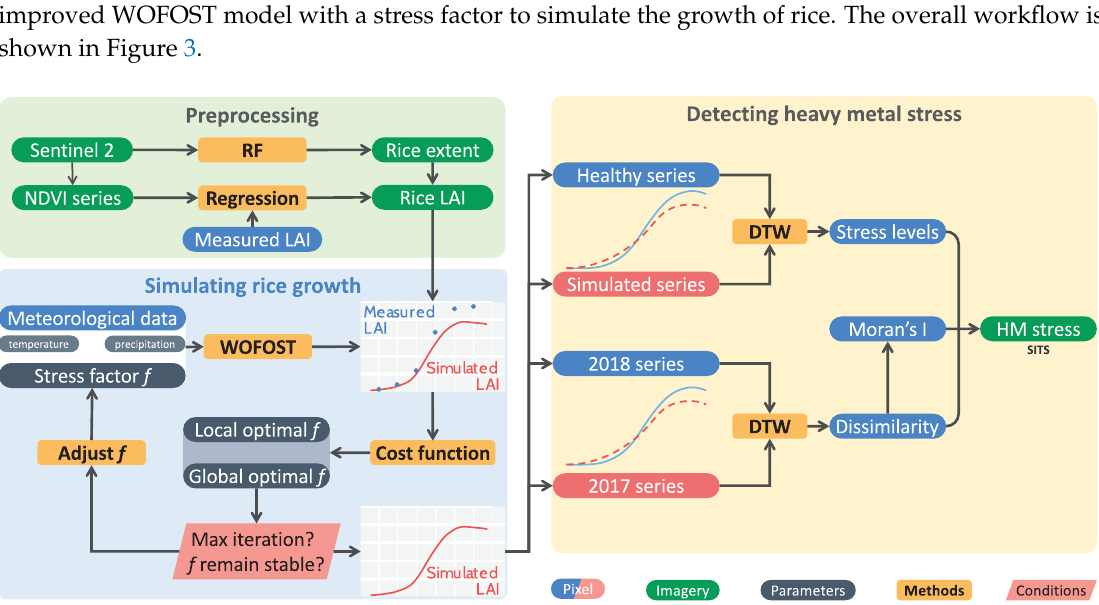
Figure 3. Methods to discriminate heavy metal stress in rice from multiple types of